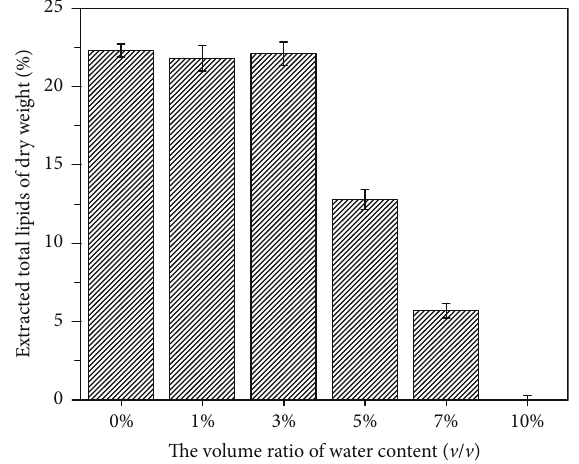
in di ff erent cycle 4 [BMIM][MeSO 4